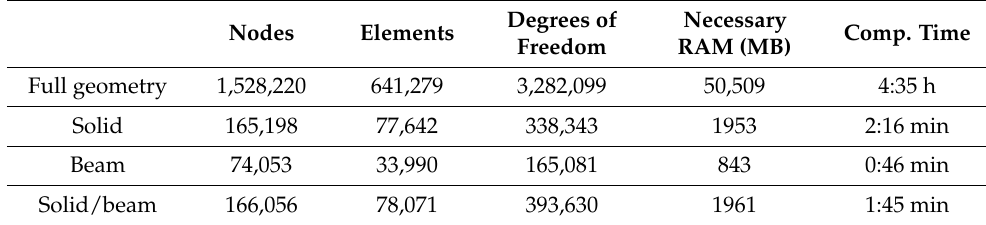
Table 7. Information on the model size, necessary RAM to load the full stiffness matrix, and